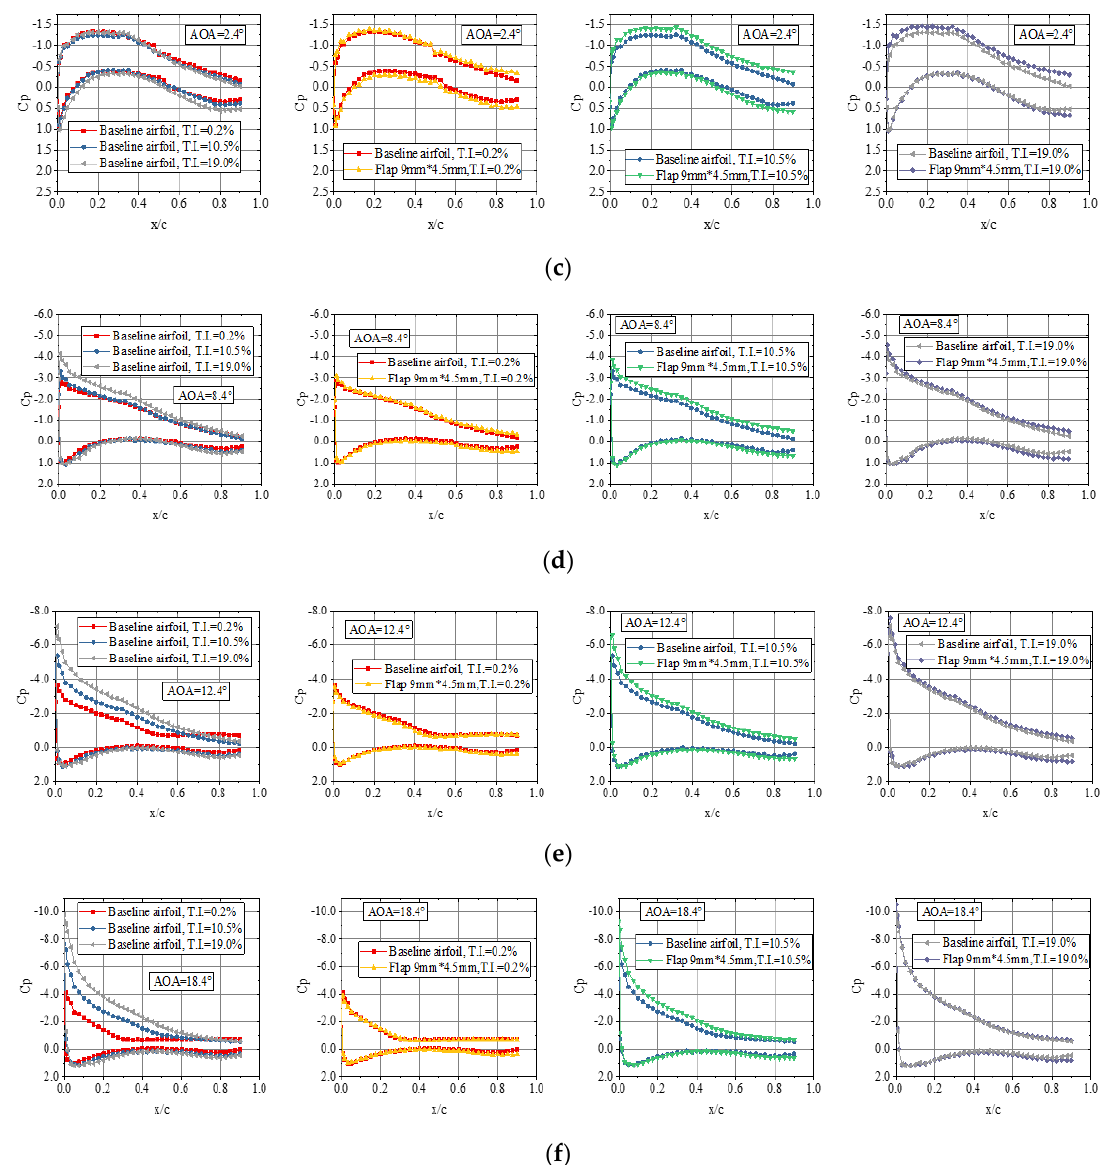
Figure 16. The surface pressure coe ffi cients under di ff erent angle of attack (Re: 0.8 × 10 6 ). ( a ) α = − 9.6 ◦ ; ( b ) α = − 3.6 ◦ ; ( c ) α = 2.4 ◦ ; ( d ) α = 8.4 ◦ ; ( e ) α = 12.4 ◦ ; (f) α = 18.4 ◦